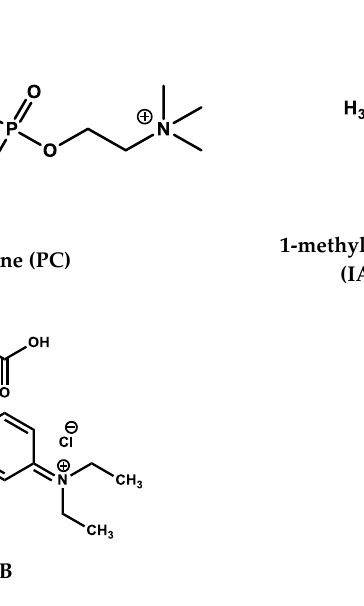
Figure 1. Chemical structure of compounds used in the work.